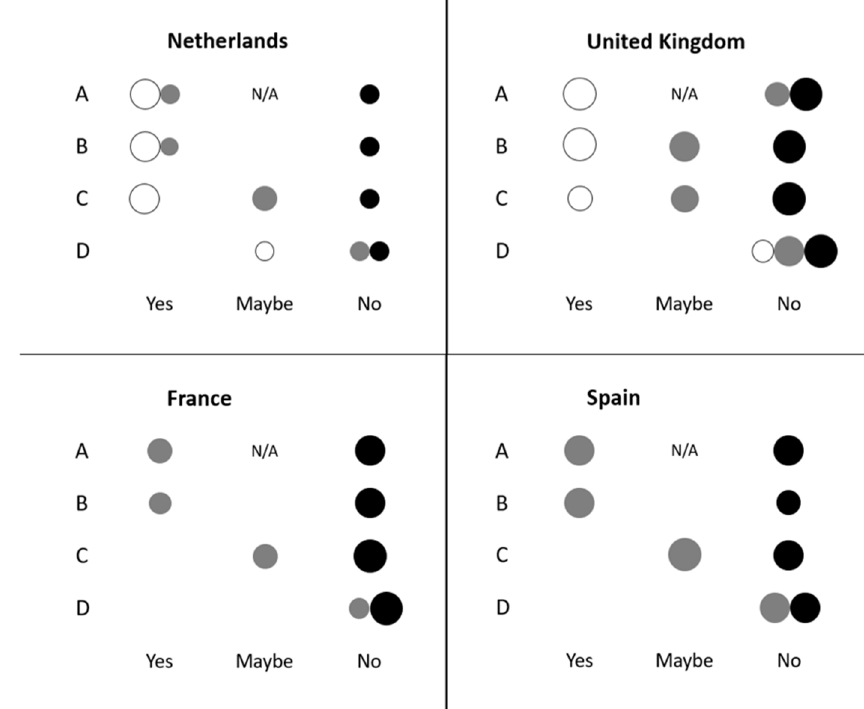
Figure 1. Cluster analyses with regards to willingness to engage with cultured meat showing the spread among each of the four categorigal variables. The size of the bubbles is indicative of the relative distribution among respondents within each variable. The categorical variables are: A, “If available, would you consider cultured muscle tissue as a source of dietary proteins?”; B, “Would you personally be willing to try cultured meat?”; C, “Would you personally be willing to purchase cultured meat?” and D, “Would you personally be willing to pay more for cultured meat?”. The colours of the bubbles represent the clusters: white = yes, willing, grey = uncertain, black = no, not willing. France, n = 484; Spain, n = 210; The Netherlands, n = 230; and The United Kingdom, n = 366. N/A and all blanks= no association.